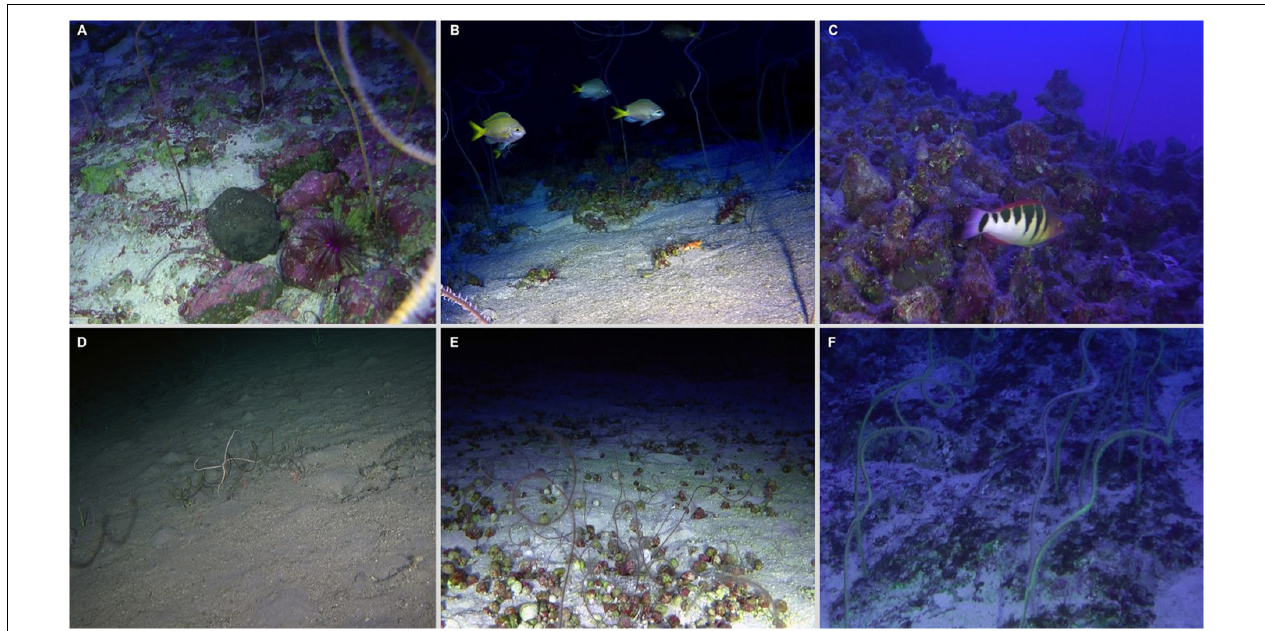
FIGURE 7 | Benthic habitat types on Apolo peak (A) , the upper slope of Rapa Nui (Easter Island) (B–D) and the summit of Pukao seamount (E,F) . (A,B,F) Small patches of irregular rock substrate, with large areas of sand, inhabited by some fishes ( Chromis mamatapara ). (C) Irregular rock bottom with fractures and faults that are dominated by incrusting red algae and are used as habitats for small fishes ( Pseudolabrus semifasciatus ). (D) Regular continuous homogeneous bottom with coarse sand. (E) Regular continuous homogeneous bottom with coarse sand, rhodoliths, and little relief. Image credit: Matthias Gorny (OCEANA) and ESMOI. be critical for revising antipatharian taxonomy. For